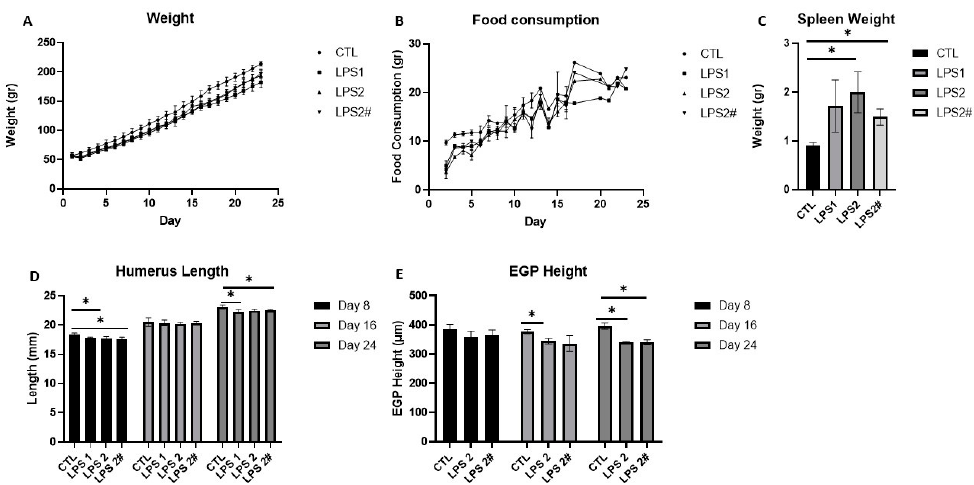
Figure 2. The effect of different doses of LPS (1 mg/kg/day, 2 mg/kg/day, and 2 mg/kg semi-daily *) on ( A ) weight, ( B ) food consumption, ( C ) spleen weight, ( D ) humerus length at 8, 16, and 24 days, ( E ) EGP height at 8, 16, and 24 days. Student’s t -test was used (control was compared to each dose); mean ± SD values are shown (n = 3 per group). LPS2 #—LPS 2 mg/kg semi-daily. * <0.05.